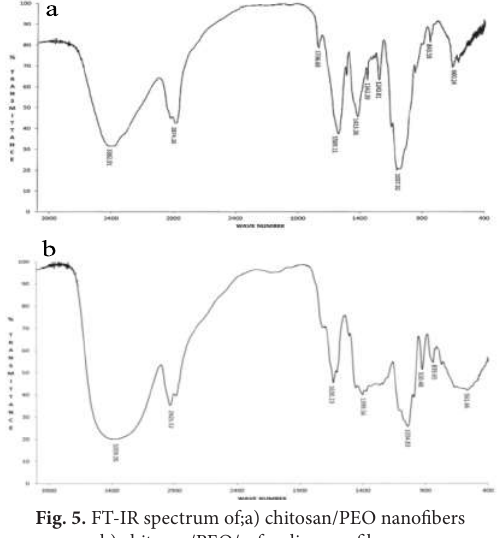
Fig. 5. FT-IR spectrum of;a) chitosan/PEO nanofibers b) chitosan/PEO/cefazolin